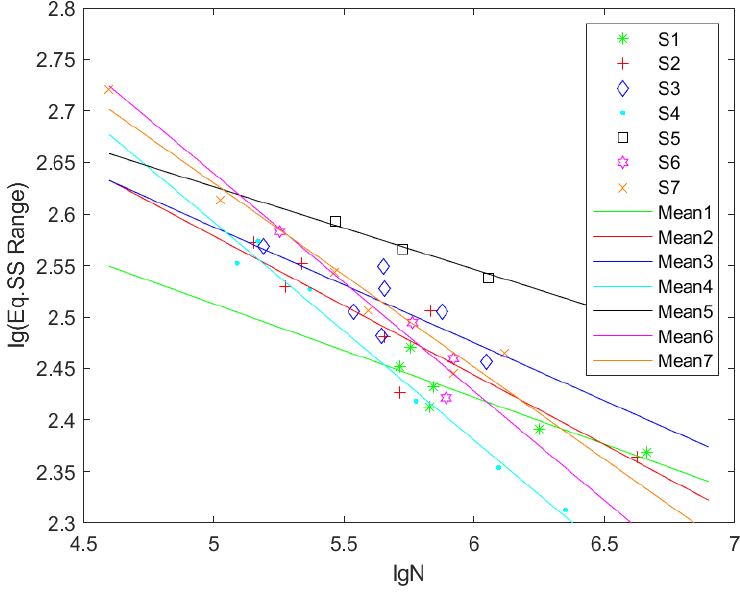
Figure 5: S-N curves based on fatigue characteristics domain.